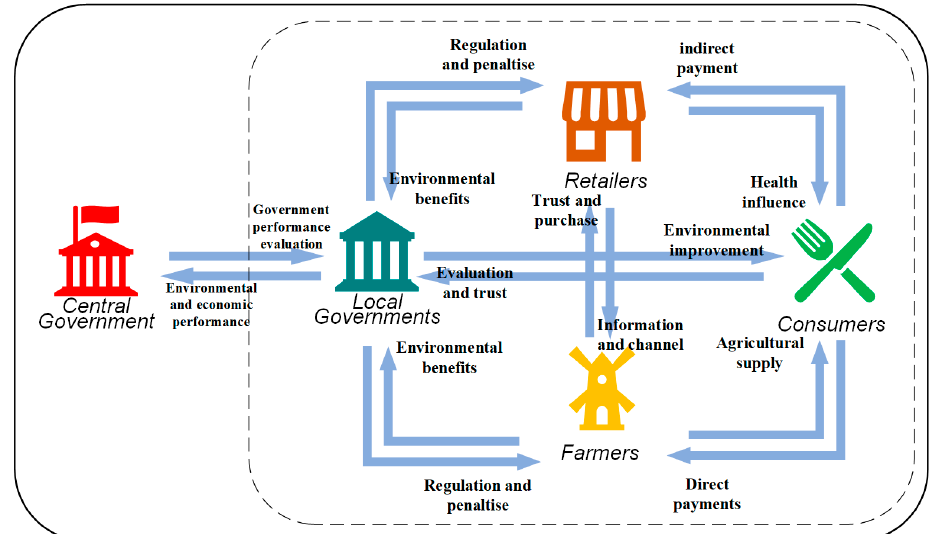
Figure 1. The logical framework of PAM stakeholders’ relationships.